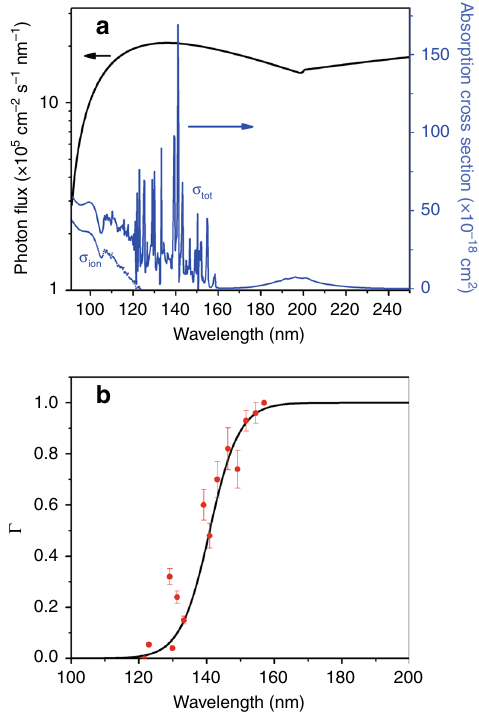
Fig. 4 The wavelength dependences of SH(X) quantum yields. Plot showing the wavelength dependences of a the general interstellar radiation fi eld (ISRF, the black line) and the total absorption ( σ tot, the blue line) and photoionization ( σ ion, the blue dotted line) cross-sections of H 2 S and b the quantum yield for forming SH(X) photoproducts, Γ (Eq. (7)), determined in the present work (the red dots). The sigmoidal function (the black line) through the latter data is used to derive the reported overall SH(X) product quantum yield. The error bars represent the standard deviation of three independent measurements. Source data are provided as a Source Data fi